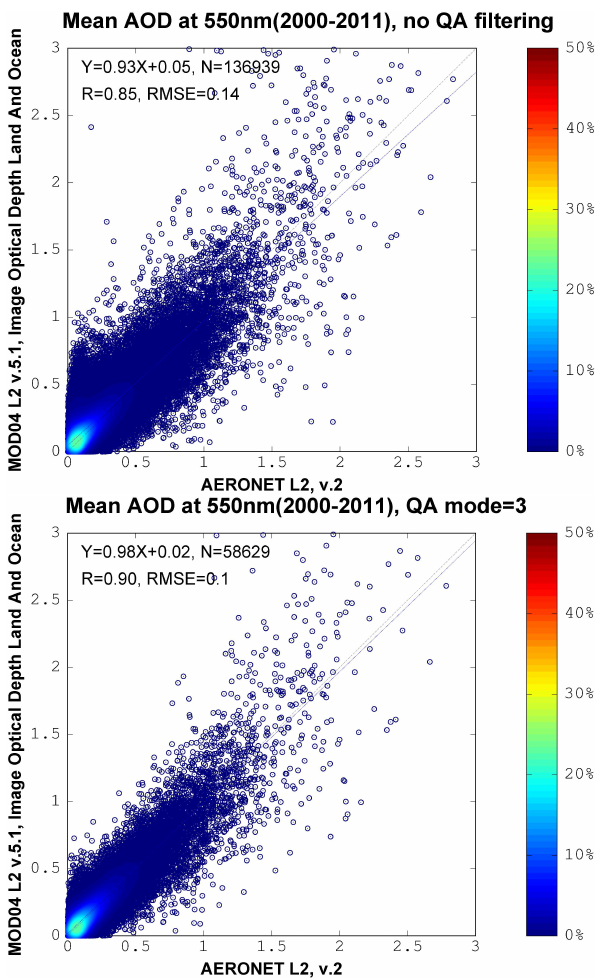
Fig. 5. Correlation coefficient ( R ) between the means of AERONET AOD and MODIS AOD at 550nm: (a) without QA screening, and (b) with the screening by the MODIS QA mode=3 (Best). AERONET data was interpolated to 550nm. The color scale high- lights the data density, indicating the percent of all data points that are distributed in a particular area of the plot.